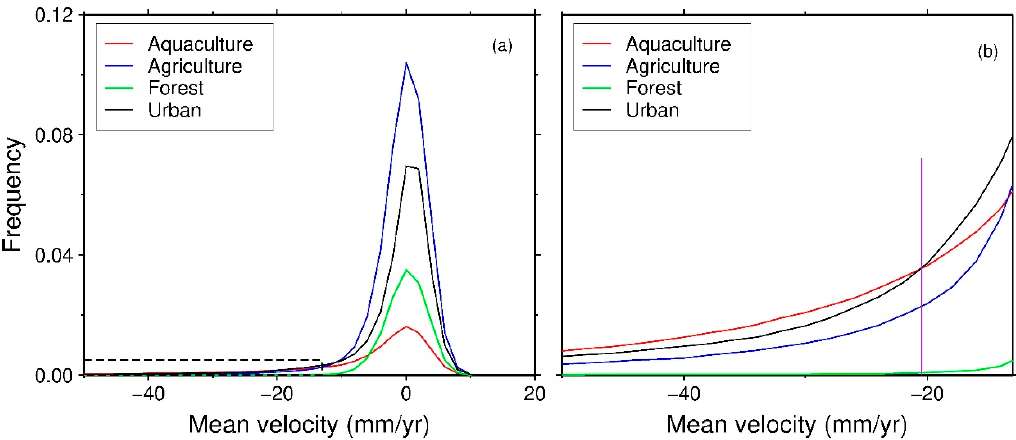
Figure 12. Average deformation velocity in the four selected land-use classes. ( b ) The enlarged view of the black dotted rectangles in ( a ). Red, blue, green and black lines represent the histograms for aquaculture, agriculture, forest, and urban areas, respectively. The horizontal axis represents the average deformation velocity. The vertical axis represents the average velocity frequency in the four land-use classes.